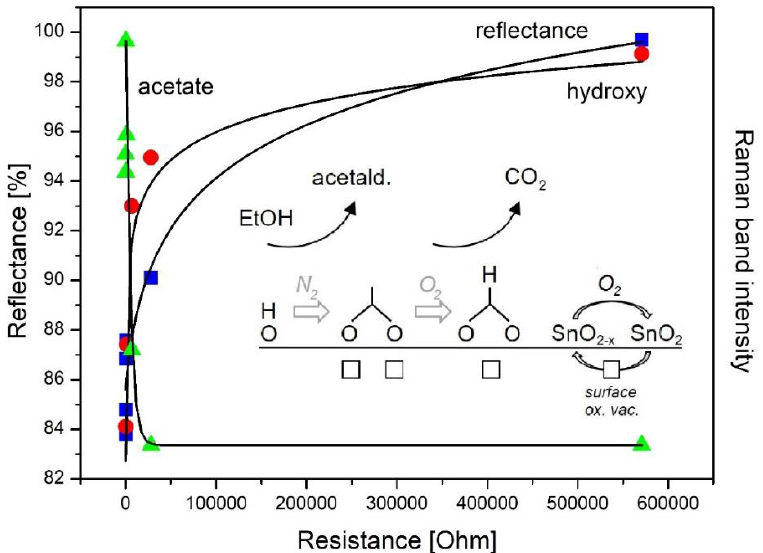
Figure 13. Proposed mechanism of the ethanol gas sensing of SnO 2 . Reflectance and Raman band intensities of hydroxy and acetate species as a function of sensor resistance, together with least-squares fits to the experimental data. Reproduced from [6].